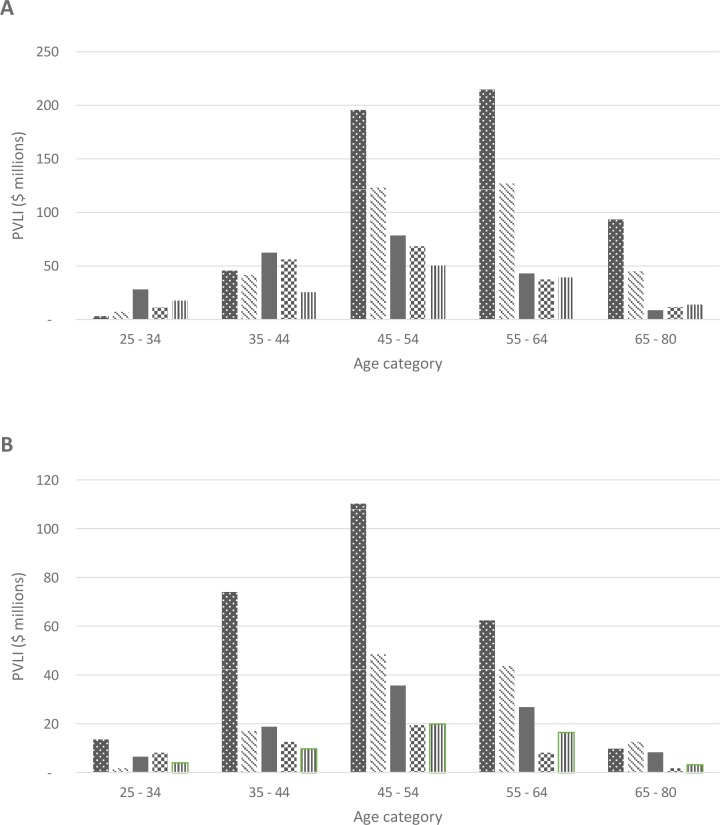
Cancer sites with the highest present value of lifetime income (PVLI) forgone, adults age 25–80 at the time of death in the year 2003.A) Men. From left to right: Lung cancer, colorectal cancer, brain cancer, melanoma, lymphoma. B) Women. From left to right: Breast cancer, lung cancer, colorectal cancer, brain cancer, ovarian cancer.